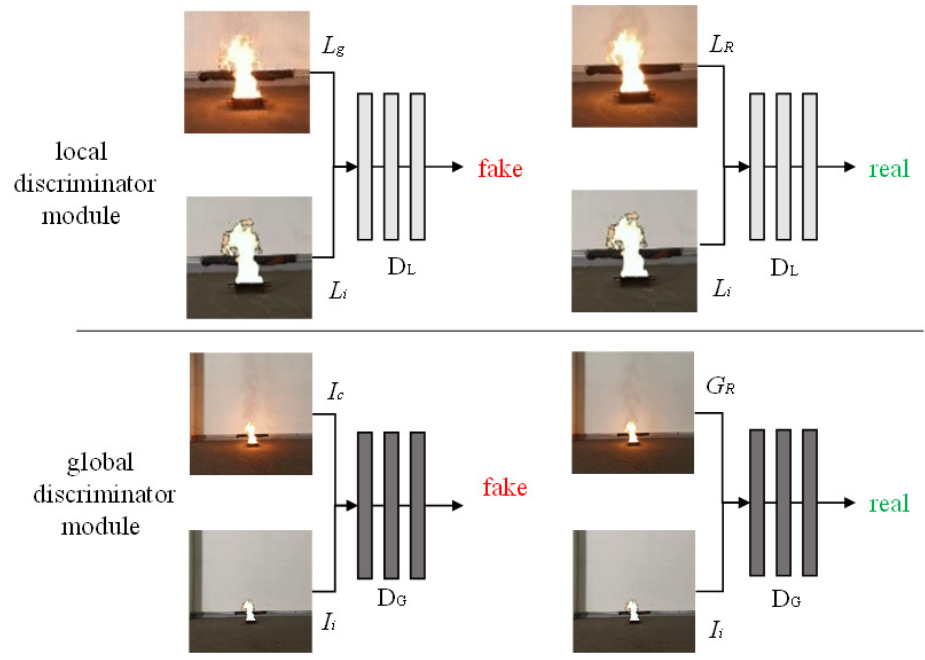
Figure 3. The discriminator structure.